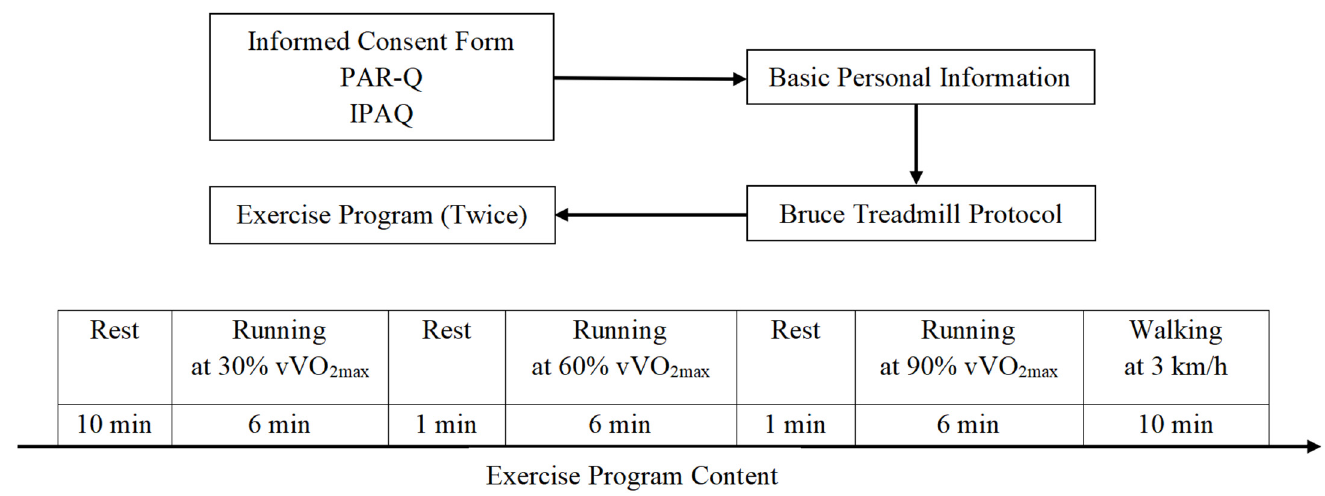
Figure 2. The study procedure. PAR-Q: Physical Activity Readiness Questionnaires; IPAQ: Interna- tional Physical Activity Questionnaire; vVO 2 max: Speed at maximum oxygen uptake.